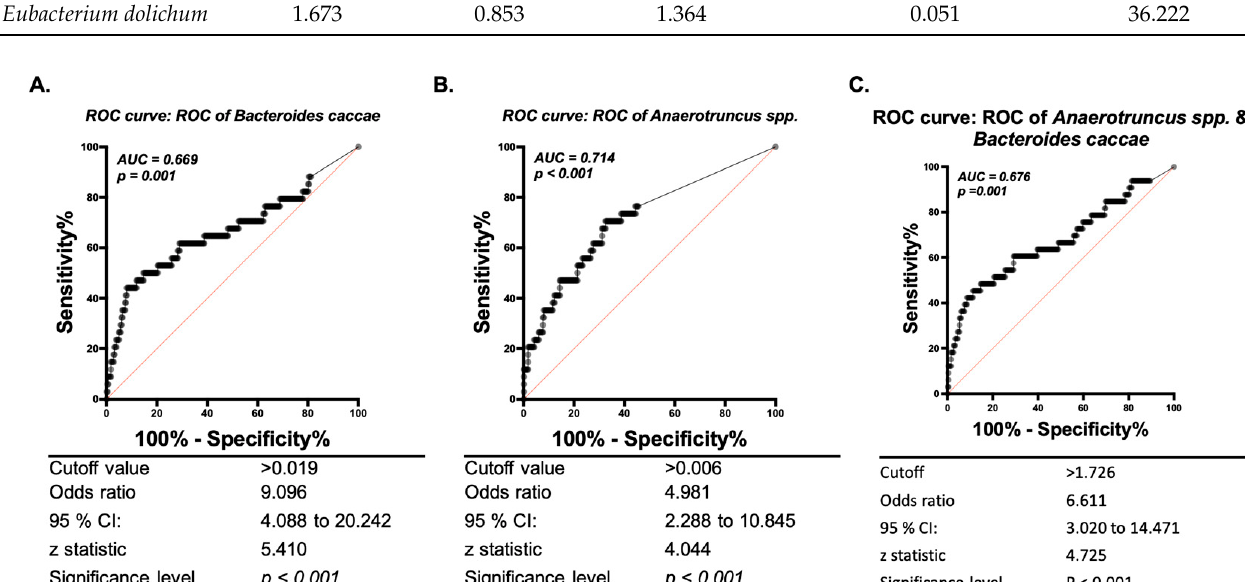
Figure 5. Bacteroides caccae and Anaerotruncus spp. may serve as predictive microbial biomarkers for the risk of NSCLC. The cutoff value in receiver operating characteristic (ROC) curve analysis was 0.8 including only good (0.8 ≤ , area under the curve (AUC) < 0.9) and excellent (AUC ≥ 0.9) biosignatures. The AUCs of Bacteroides caccae ( A ), Anaerotruncus spp. ( B ), and the combination of the abundances of both bacteria ( C ) in predicting NSCLC risk were analyzed separately.